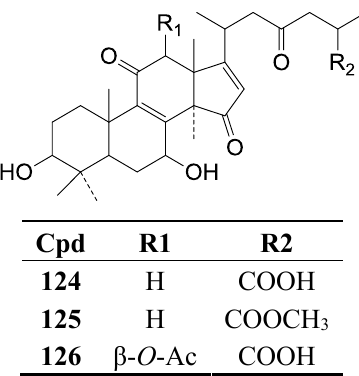
Figure 10. Structures of compounds 124 – 126 .